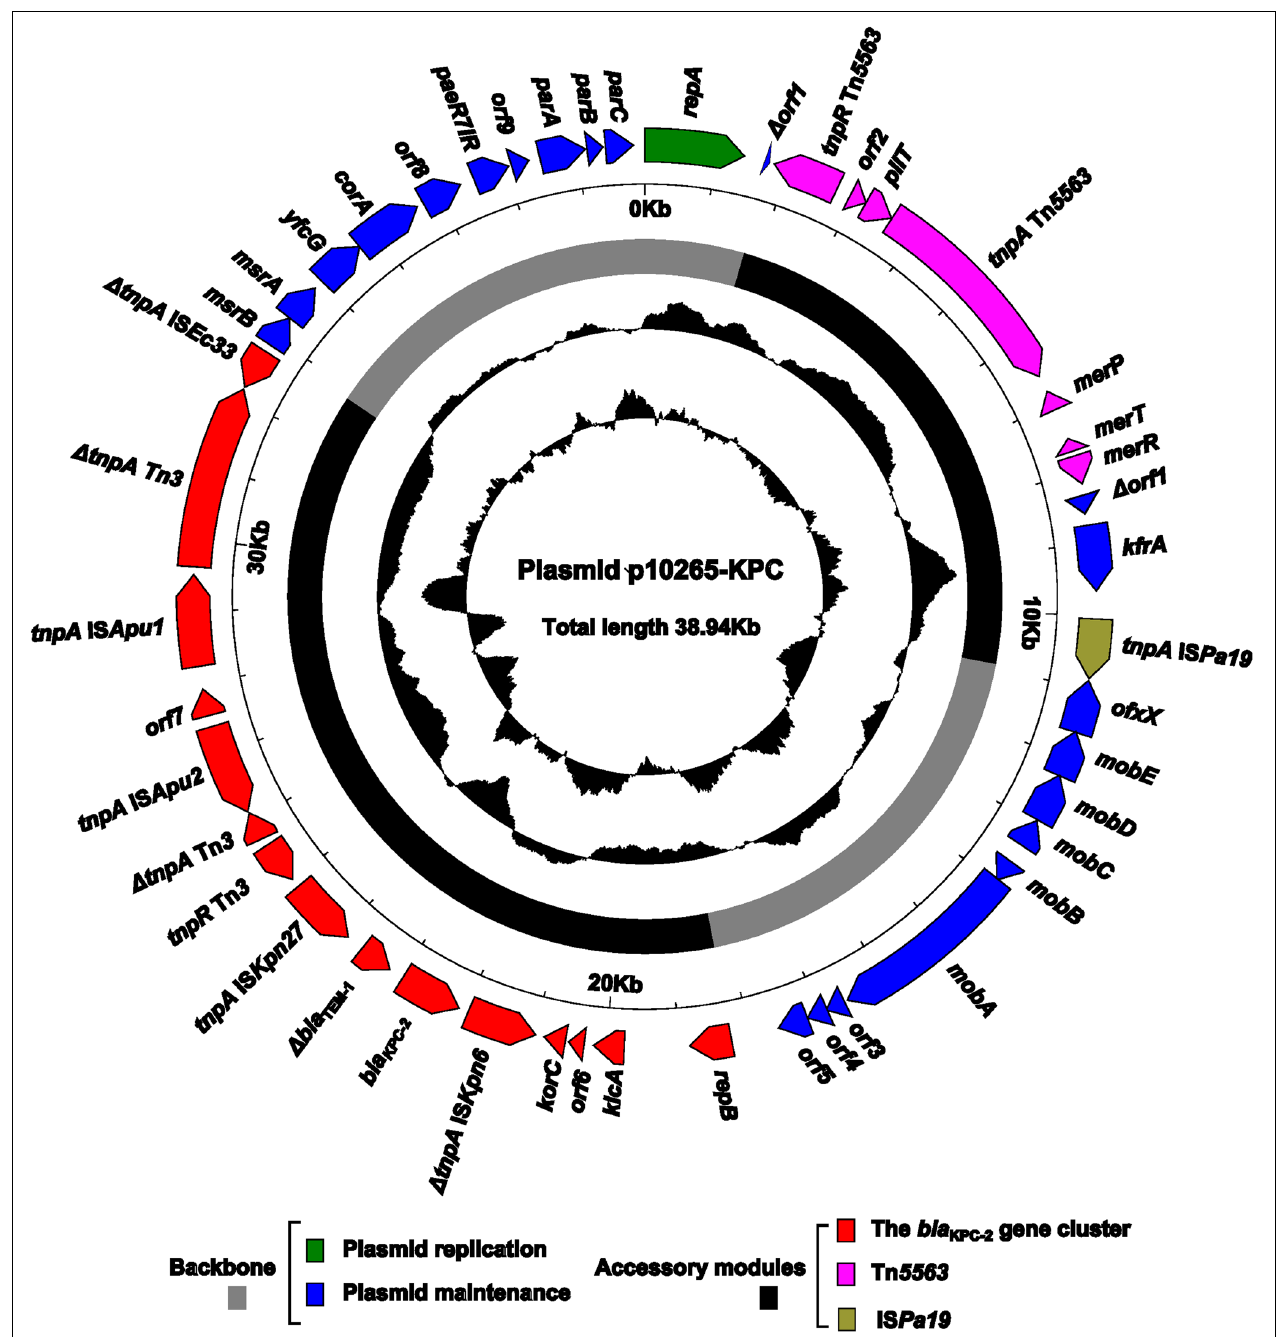
FIGURE 1 | Schematic maps of p10265-KPC. Genes are denoted by arrows and colored based on gene function classification. The innermost two circles indicate the GC-Skew [(G-C)/(G + C)] and the GC